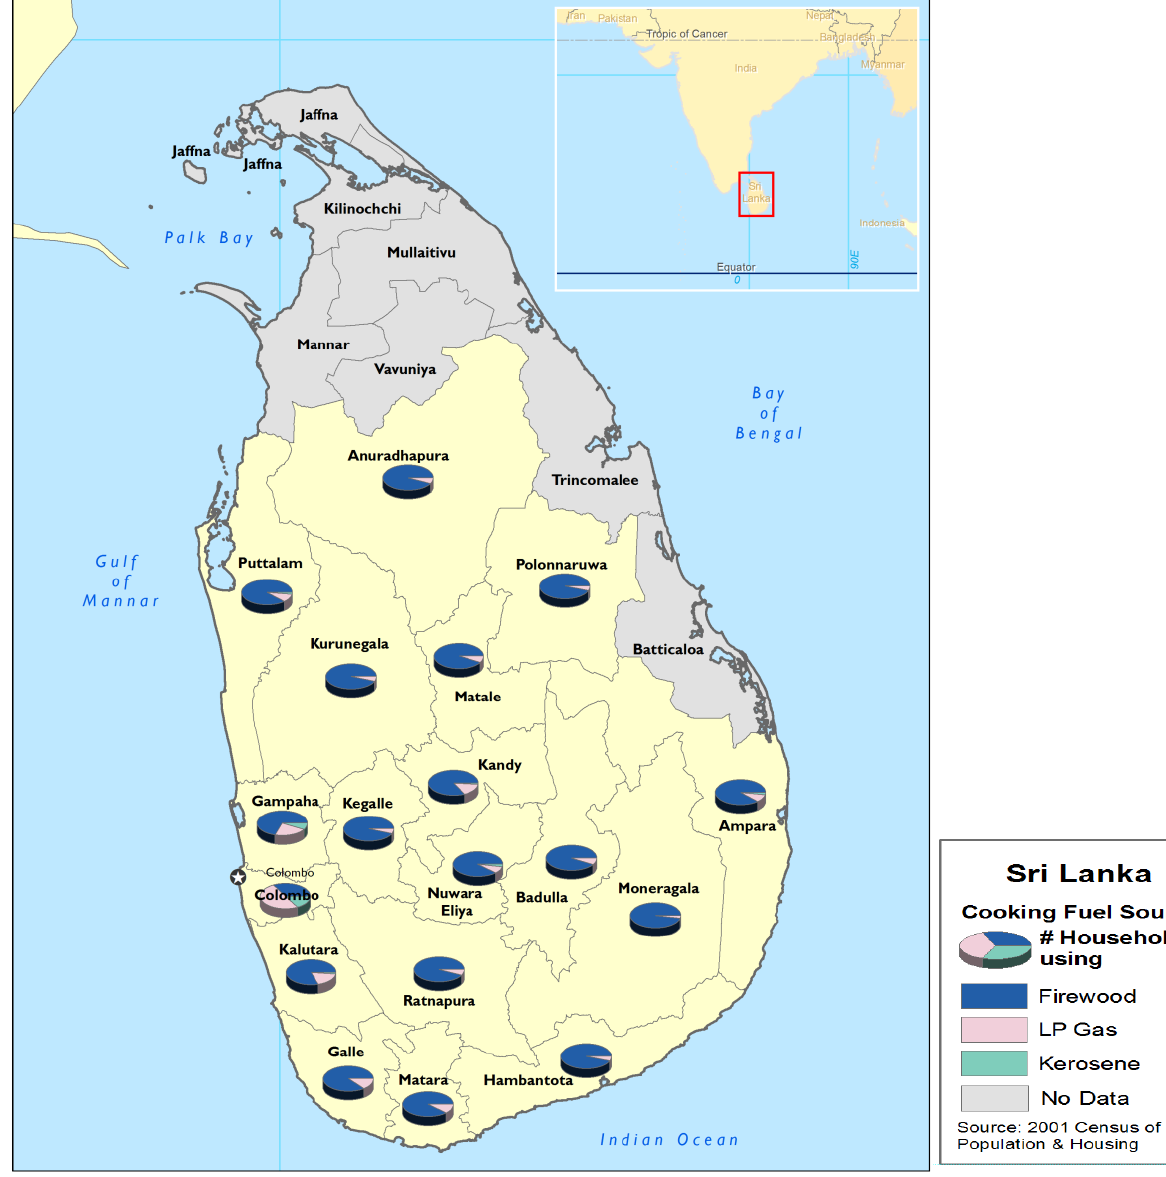
Figure 2. Sri Lanka cooking fuel source by